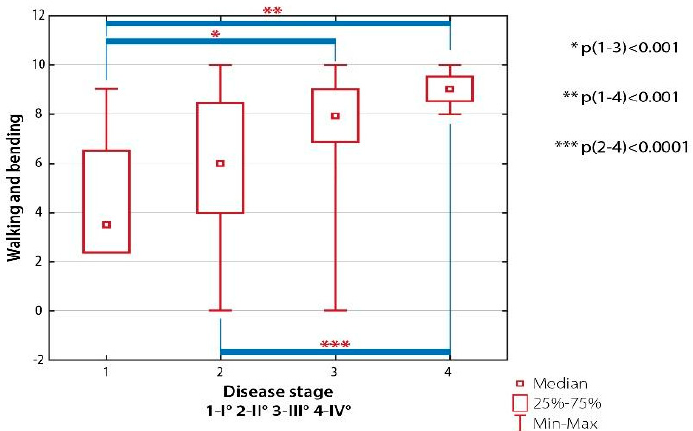
Figure 3. Inter-group differences in the quality of life evaluated with AIMS-2: walking and banding domain, depending on the severity of radiological changes (the Steinbrocker classification).